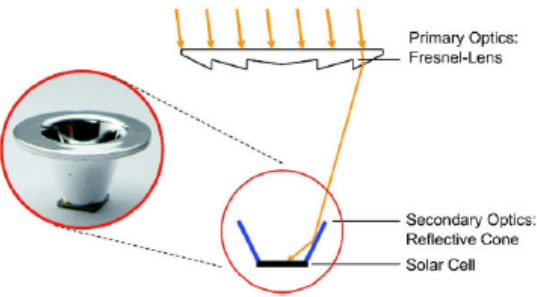
Figure 29. Schematic view of the secondary optics used with the Fresnel lens [56]. Reprinted